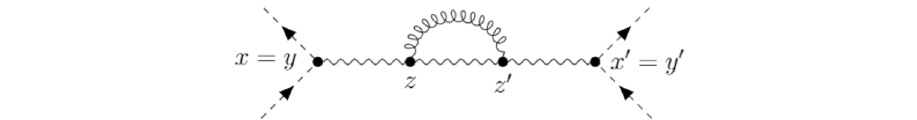
Figure 1 . This diagram shows how the vacuum polarization contributes to the amputated 4-scalar vertex function. Dashed lines represent massive scalars, wavy lines represent photons and curly lines represent gravitons. These graphs have the same topology as Bjerrum-Bohr’s Diagram 8